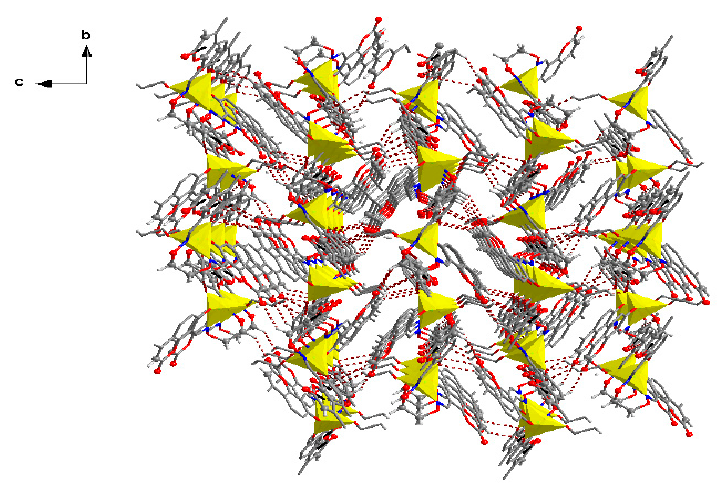
Figure 3. View of the 3D supramolecular structure of complex 1 showing the O-H ··· O, C-H ··· O, hydrogen bonds, and C-H ··· π stacking interactions.